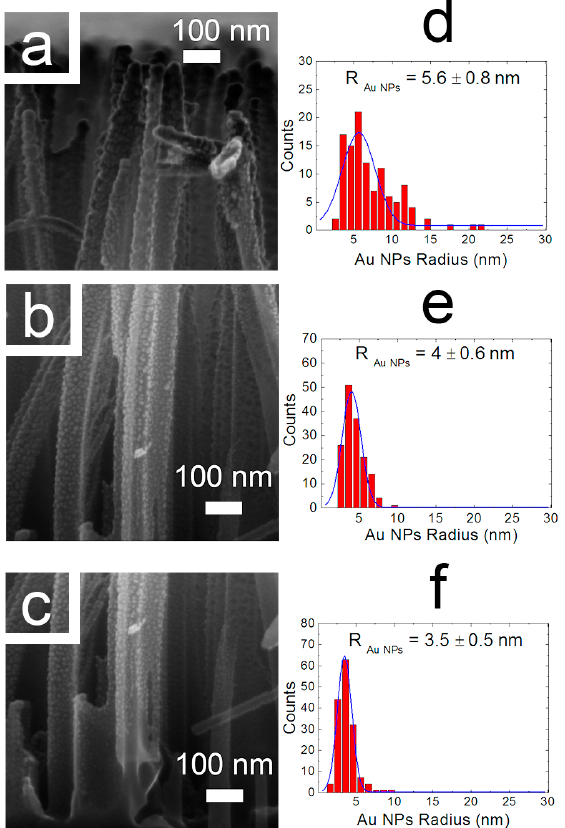
Figure 2. Cross-section SEM images (Field Emission Zeiss Supra 25 Microscope) of the ( a ) top, ( b ) center and ( c ) bottom regions of a 1.5 µ m long SiNW array decorated with AuNPs. The statistical analysis of the AuNPs radius measured for the decorated sample are reported for the top ( d ), center ( e ) and bottom ( f ) sections,